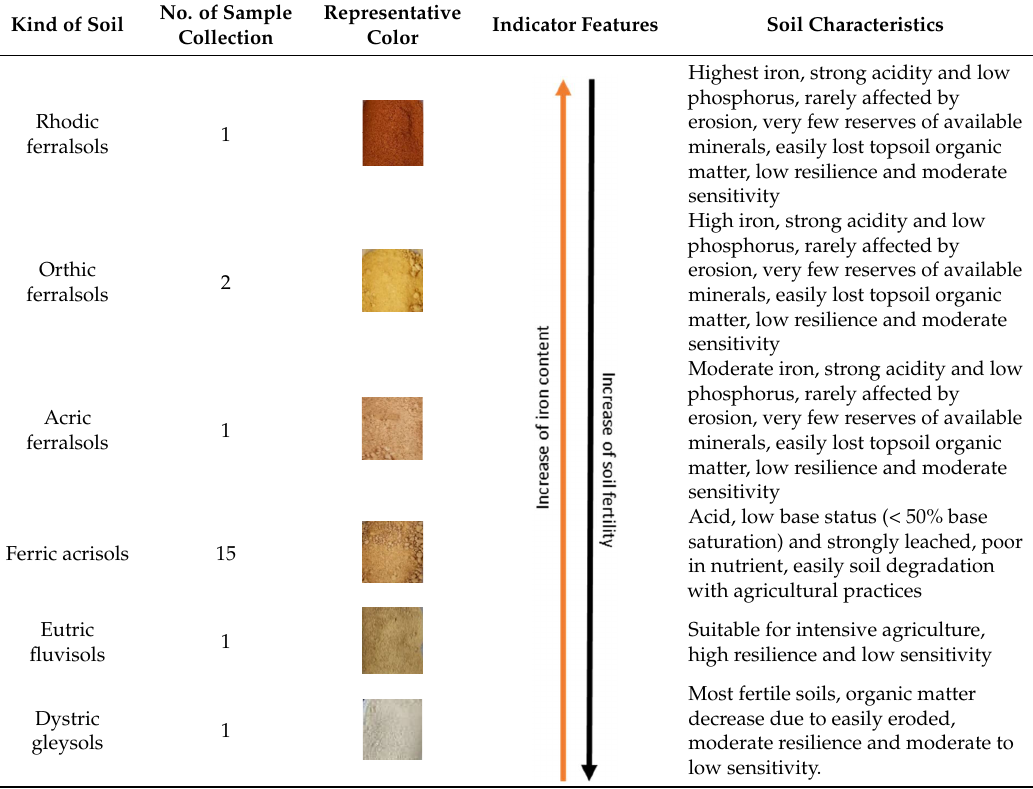
Table 1. Features of soil samples and soil types in the study basing the description of FAO [28]. Kind of Soil